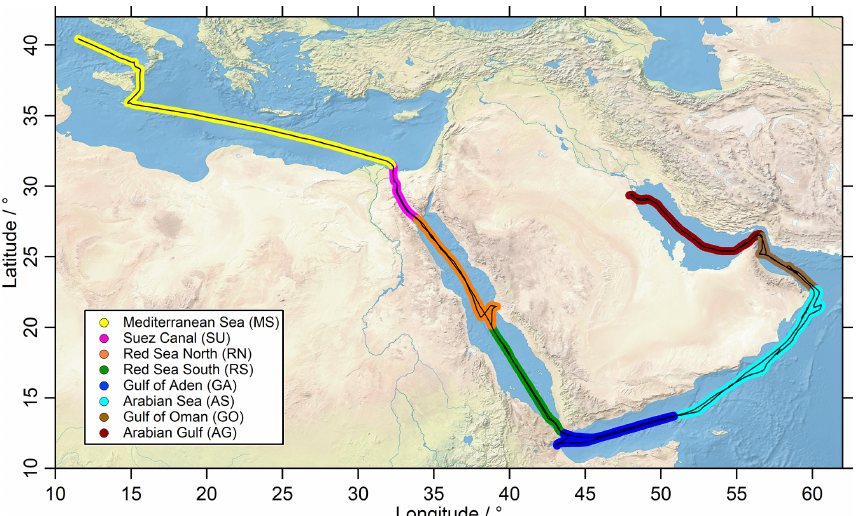
Figure 1. The ship track (black) of the Kommandor Iona during the AQABA cruise subdivided according to different chemical regimes into eight regions: Mediterranean Sea (MS: yellow), Suez Canal (SU: pink), Red Sea north (RN: orange), Red Sea south (RS: green), Gulf of Aden (GA: blue), Arabian Sea (AS: turquoise), Gulf of Oman (GO: brown) and Arabian Gulf (AG: red). HYSPLIT trajectories for the respective regions are presented in the Supplement (Figs. S17, S18). The map was created with data provided by the Natural Earth website (http://www.naturalearthdata.com, last access: 3 June